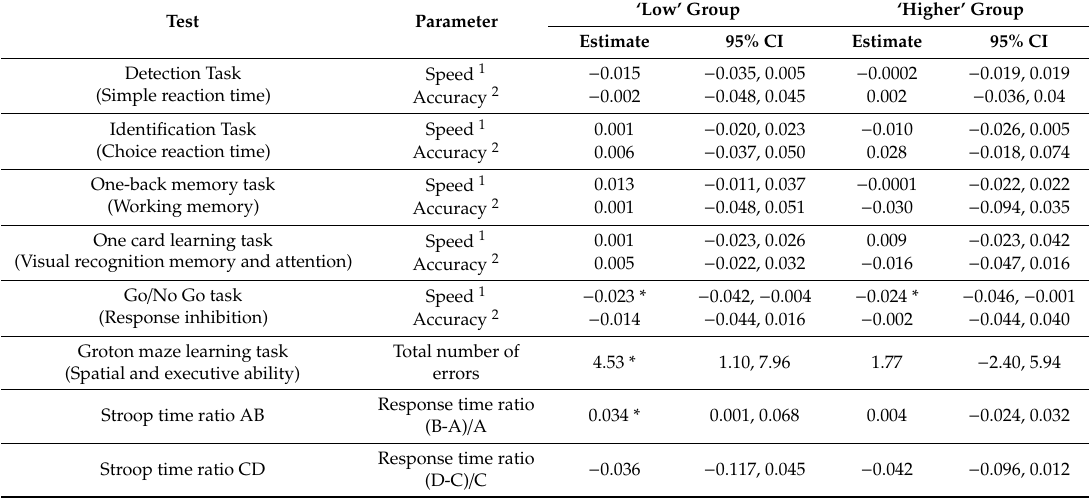
Table 3. Di ff erence in adjusted means for cognitive outcome scores by ‘annual cumulative mobile exposure’